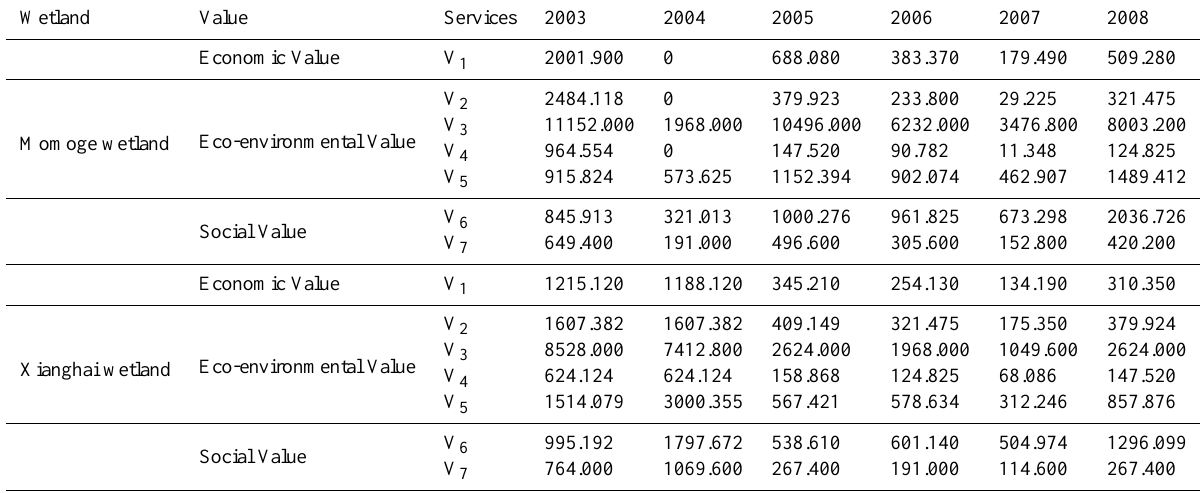
Table 3. Floodwater utilisation value of wetland services from 2003 to 2008 (10 4 RMB).